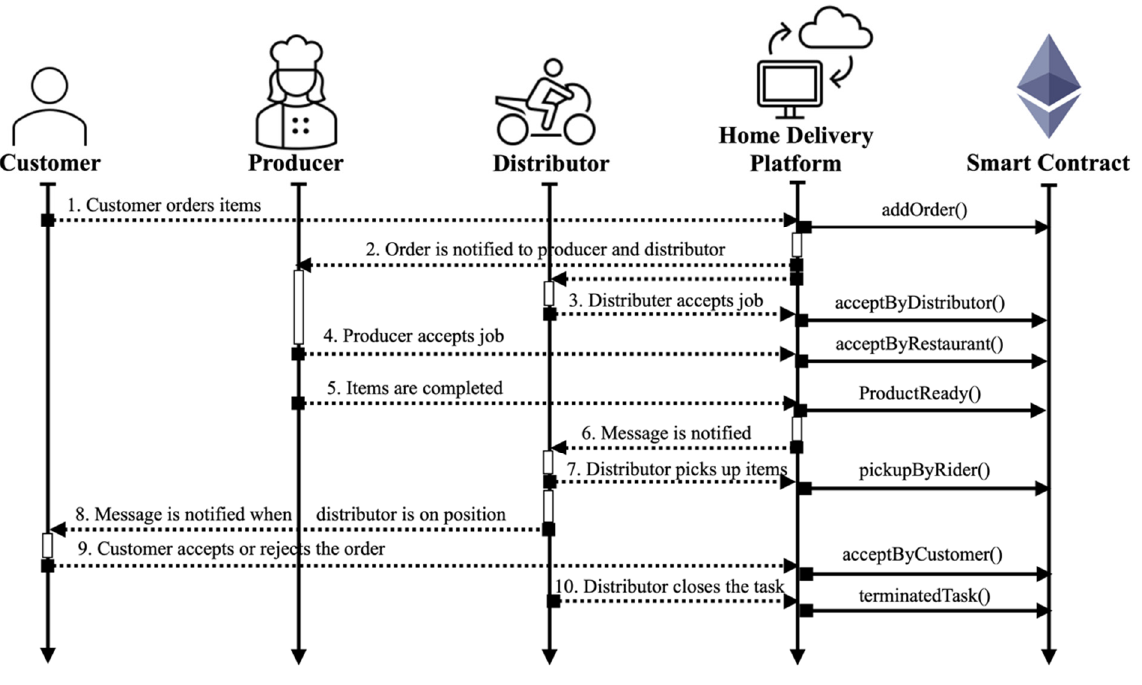
Figure 2. The workflows of the proposed architecture. The dotted line represents the traditional operation of the home delivery platform, while the solid line represents the methods in the smart contract. This diagram shows the write permission method only because they consume gasUsed . Table 2. The smart contract method to secure a home delivery model.